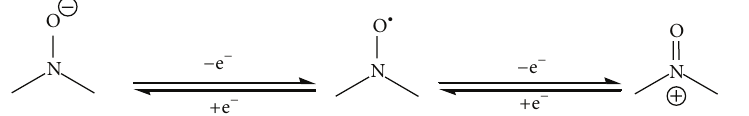
Figure 1: Redox couple of the nitroxide radical.